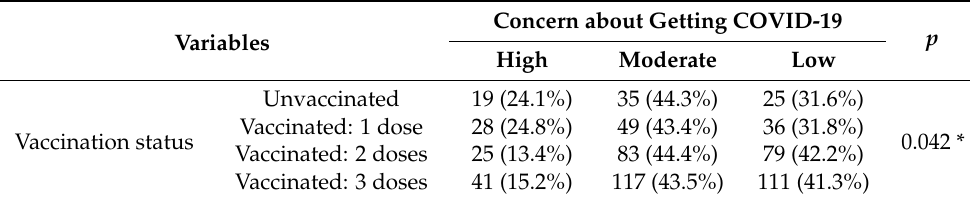
Table 7. Association between concern about the spread of COVID-19 and the vaccination status of the participants.